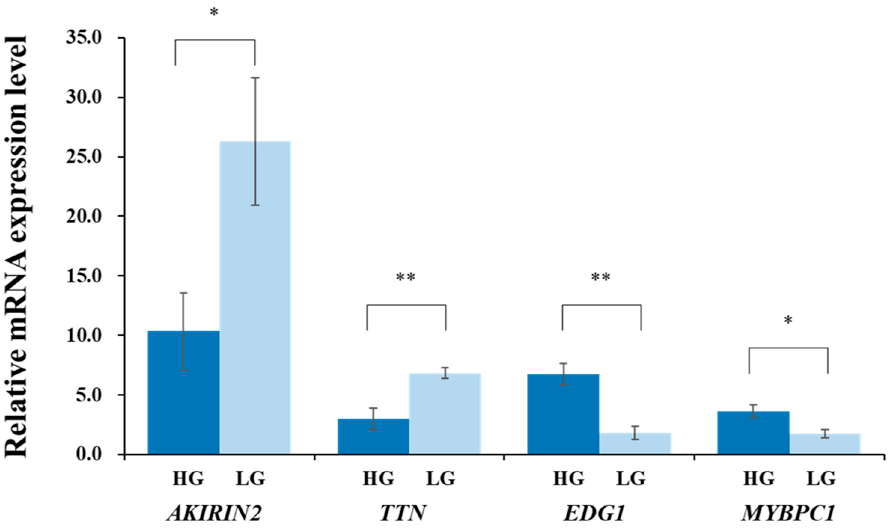
Figure 1. Expression levels of AKIRIN2 , TTN , EDG1 , and MYBPC1 genes in longissimus muscle of Qinchuan cattle with high and low intramuscular fat content. High group (HG): five Qinchuan cattle with high intramuscular fat (IMF) content. Low group (LG): five Qinchuan cattle with low IMF content. Values are the means ± SE. * p < 0.05, ** p < 0.01.